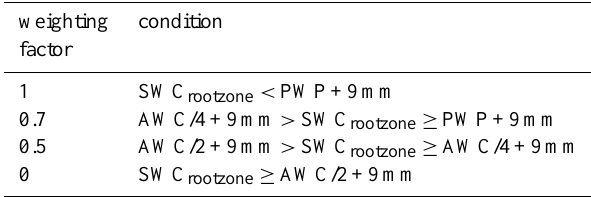
Table 1. Weighting factors for drought stress index SWC depending on SWC rootzone